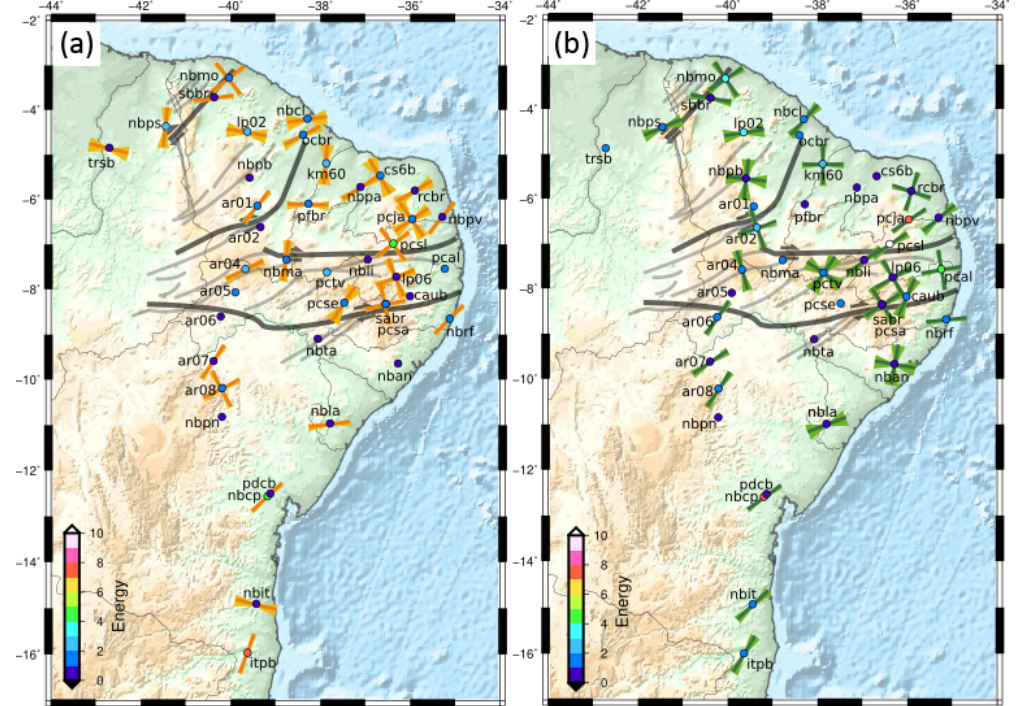
Figure 6. (a) Map of symmetry directions (dark lines) obtained for the crust (0–32km). When one line is plotted at the station, it represents either the trend of the dip in the case of dipping interface or the trend of the fast axis in the case of plunging anisotropy. When two lines are plotted, they refer to the fast axis and to its perpendicular direction in the case of horizontal anisotropy. Light colors represent 2 σ uncertainties estimated from the bootstrap (after resampling 200 times). (b) Same for the lithospheric mantle (32–100km). Station symbols have been color-coded according to the energy level of the dominant harmonic